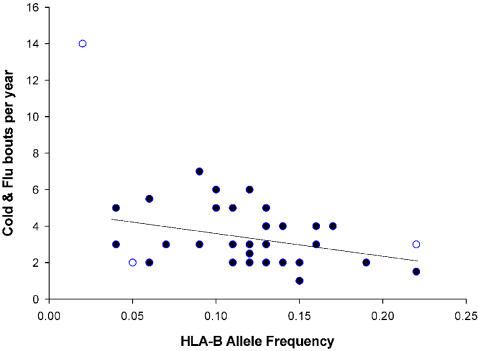
The relationship between HLA-B allele frequency and the number of self reported cold and flu bouts per year.Outliers are indicated as open circles.